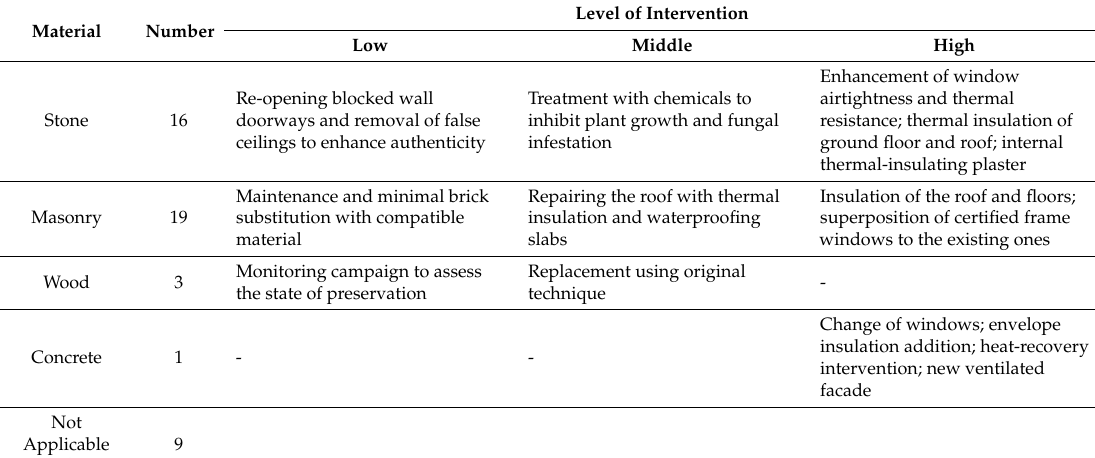
Table 2. Categorisation of publications by primary building constructive material, number of related publications, and most common performed